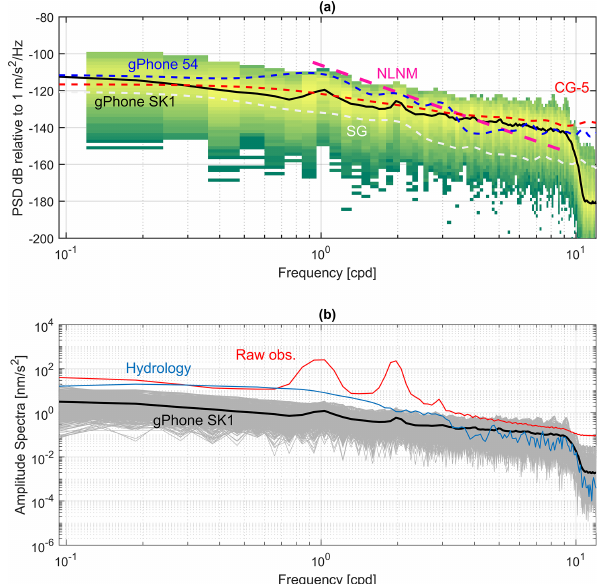
Figure 3. (a) Power spectral density (PSD) of the Škocjan gravity residuals. Frequency is expressed in cycles per day (cpd). Coloured patches: histogram showing the distribution of the PSDs; colour code proportional to the number of PSD values for given intervals of frequency and decibel (dB). Black solid line: median PSD. For comparison, median PSD of gravimeters installed in a Strasbourg station (Riccardi et al., 2011): dashed blue line: gPhone 54; dashed red line: PSD of the Scintrex CG-5; dashed white line: PSD of the Superconducting gravimeter SG-C026. Purple thick dashed line: New Low Noise Model according to Petersen (1993). (b) Ampli- tude spectrum of the Škocjan gravity residuals. Grey lines: individ- ual spectral estimates. Solid black line: median value; blue curve: amplitude spectrum of the flood event in February 2019; red line: average amplitude spectrum for observations including tidal contri- bution and atmospheric